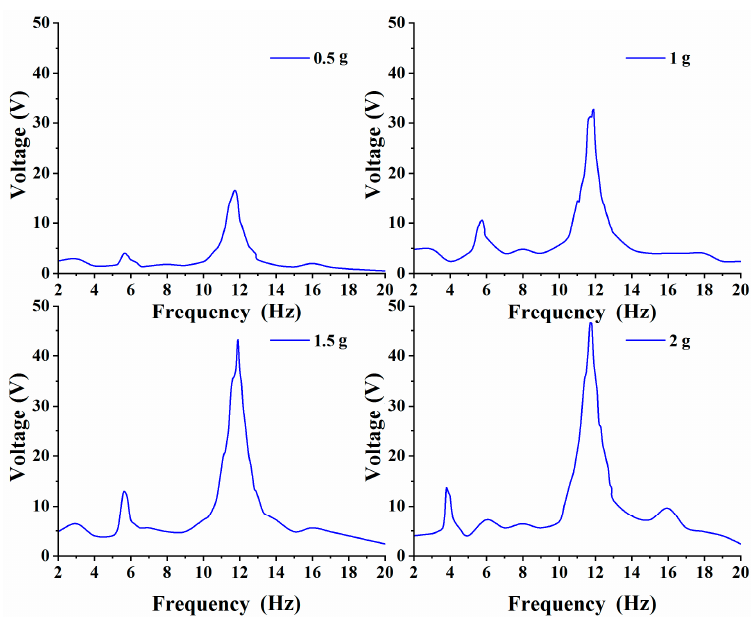
Figure 7. Open-circuit voltages of various excitation.